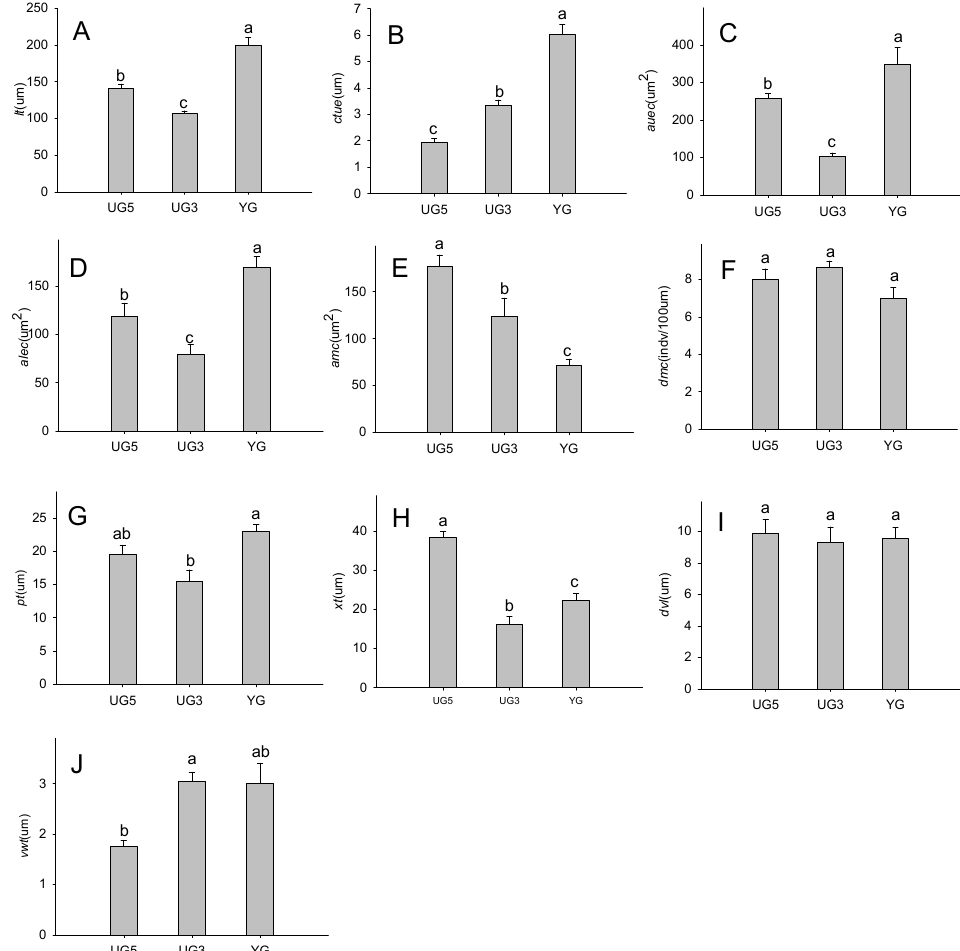
Figure 2. Effects of overgrazing and enclosure on ( A ) leaf thickness, ( B – D ) epidermal cuticle, ( E , F ) mesophyll cells, ( G , H ) phloem and xylem thickness, and ( I , J ) vessels. Significant differences are indicated by lowercase letters ( p < 0.05). Data are presented as the mean ± standard error. Abbrevi- ations: lt , leaf thickness; uect , upper epidermal cuticle thickness; auec , area of the upper epidermal cells; alec , area of the lower epidermal cells; amc , area of mesophyll cells; dmc , density of mesophyll cells; pt , phloem thickness; xt , xylem thickness; dvl , diameter of vessels; vwt , vessel wall thickness.